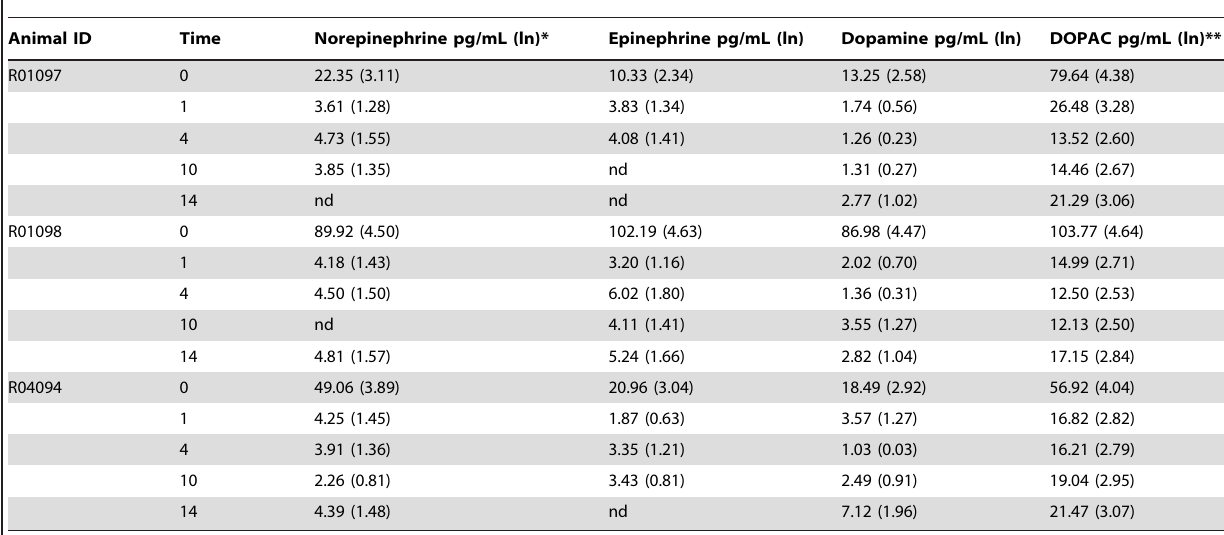
Table 5. Circulating plasma catecholamine levels (pg/mL) at baseline (0) and at 1, 4, 10, and 14 weeks after 6-OHDA in three animals.